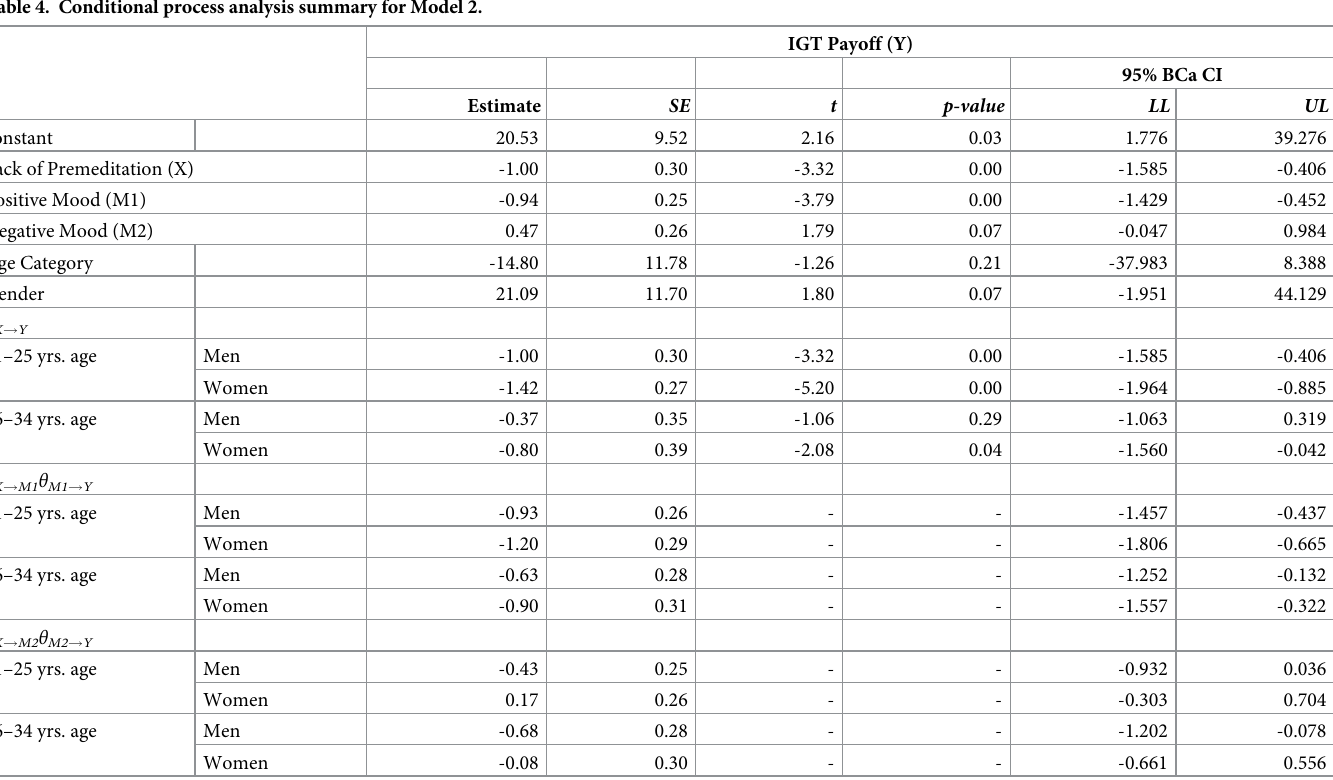
Table 4. Conditional process analysis summary for Model 2.